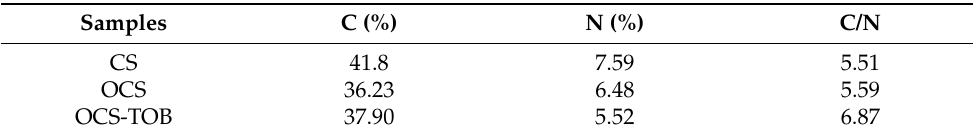
Table 1. Mass percentage of C and N in CS, OCS and